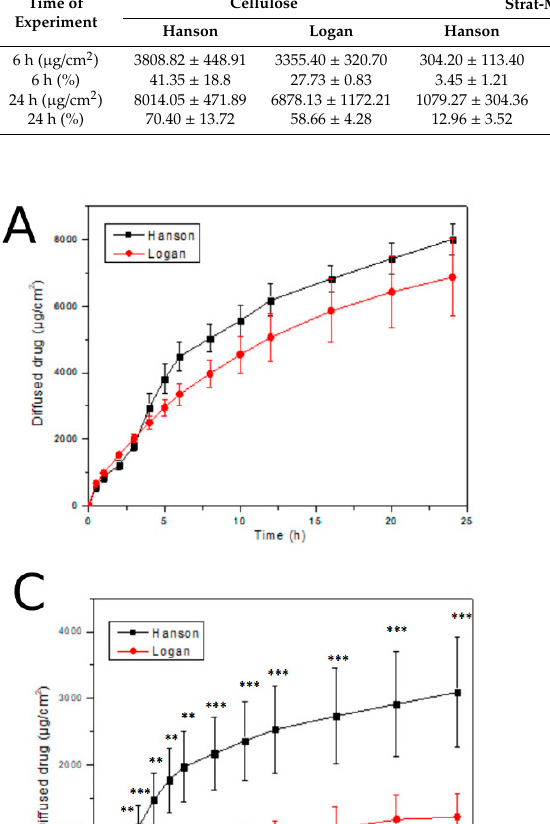
Table 4. The mean cumulative amount and percentage (%) diffused or penetrated at 6 and 24 h ( µ g / cm 2 ). Cellulose Strat-M ® HSE Cellulose Time of Experiment